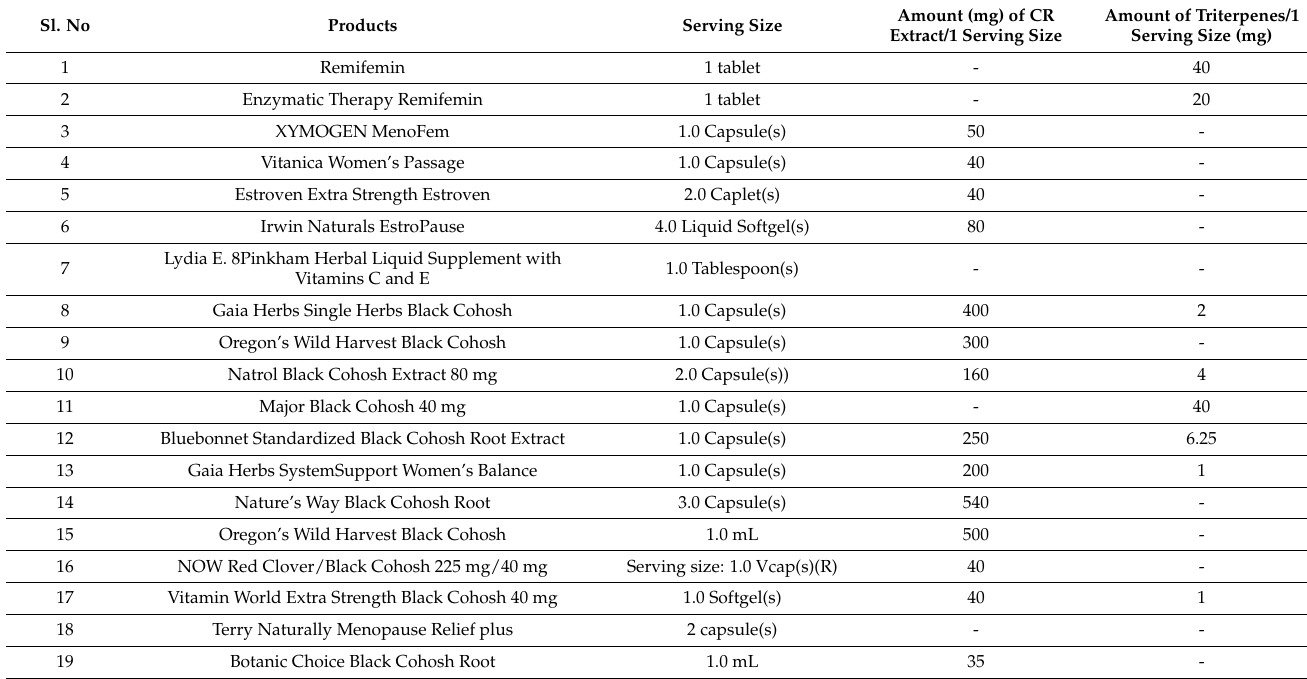
Table 1. Available commercial products of CR on the US